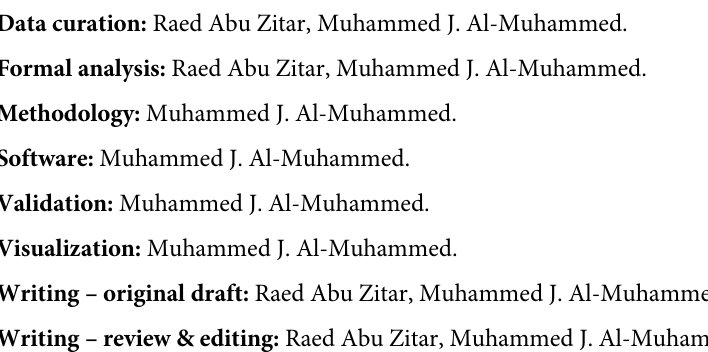
S1 Fig. Complete specification of the encryption processes using neural network without the distortion